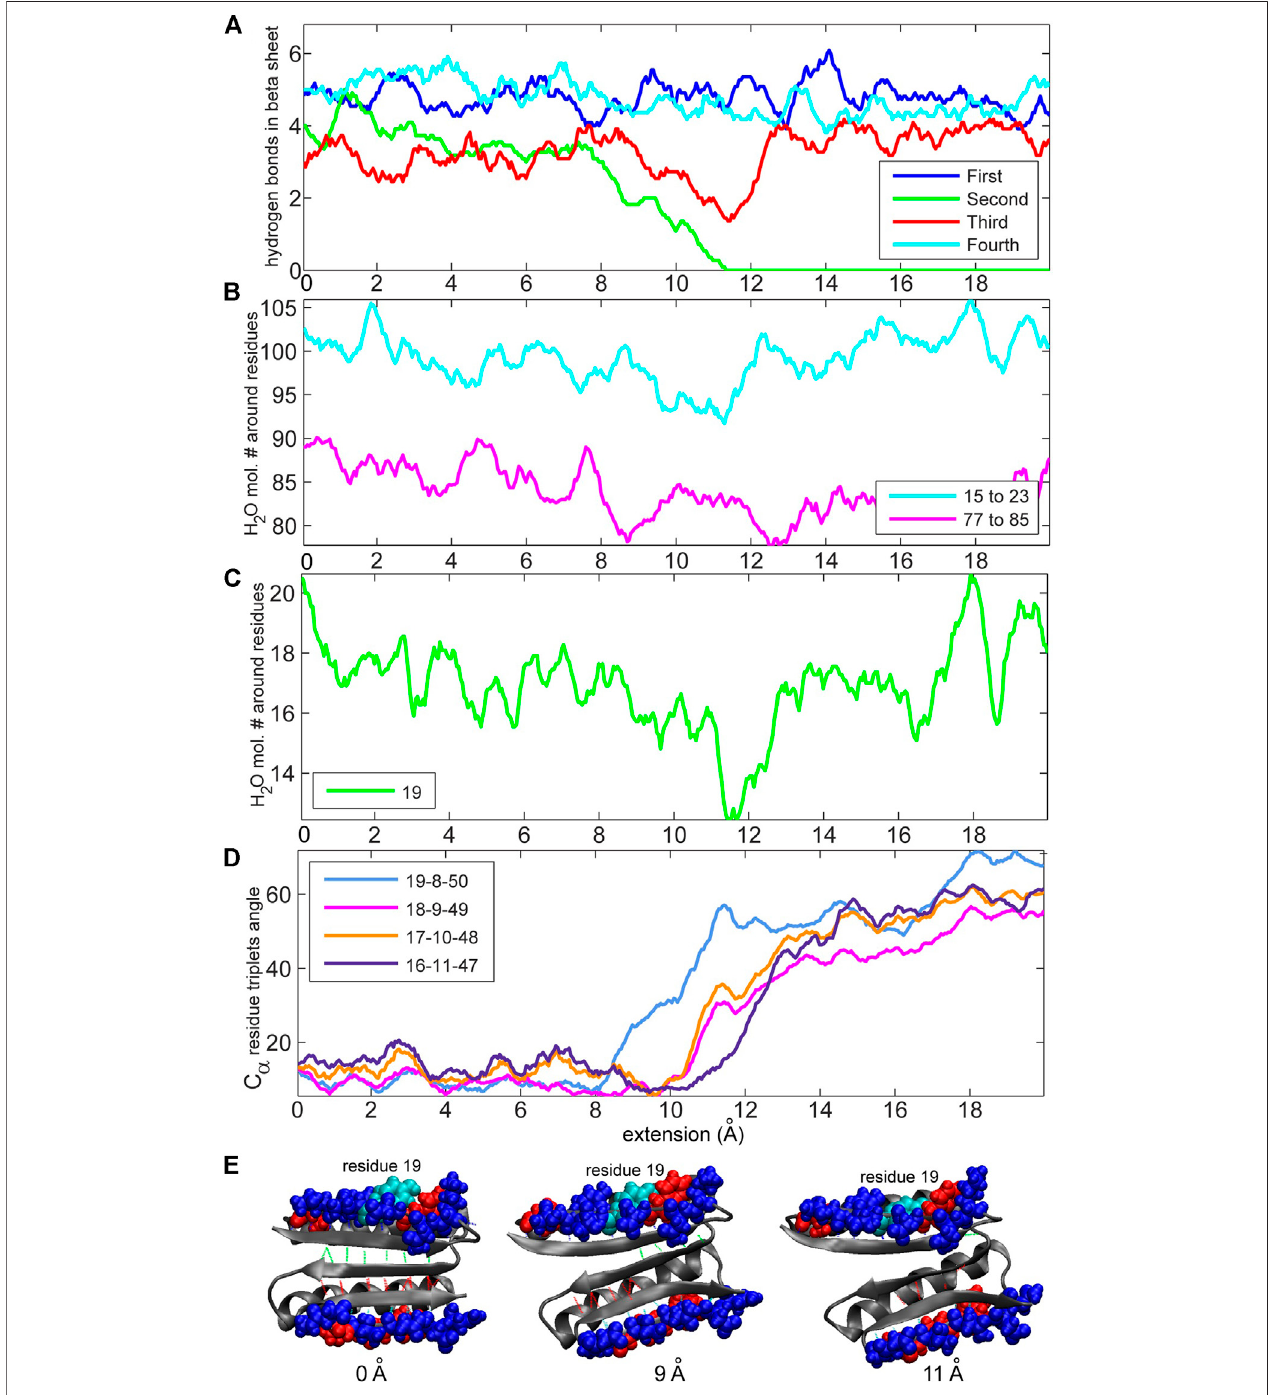
FIGURE 6 | Analyses of the numbers of hydrogen bonds vs. the concentration of water molecules and residue triplet angles (see Methods section) for the 10 m/s trajectory. (A) Numberofhydrogenbondsduringthesimulation.Thevaluesareobtainedthroughlow-pass fi ltering(movingaveragewithwindowwidth11frames,or ± 5 frames about sampling points). (B) Numbers of water molecules near residues 15 – 23 and 77 – 85. (C) Number of water molecules near residue 19. (D) Residue triplet angles for residue triplets 19 – 8 – 50, 18 – 9 – 49, 17 – 10 – 48, and 16 – 11 – 47 (triplet 19 – 8 – 50 is discussed in the text; the others are shown for comparison purposes). (E) Structure of the protein during pulling. Residue 19 (tyrosine is hydrophobic with a polar side chain) is colored cyan. Hydrophobic residues (15 – 23 and 77 – 85) are colored red, and hydrophilic residues are colored blue. Hydrophobic and hydrophilic residues in Figures 6 , 8 are displayed with VMD (Humphrey et al., 1996) by using the built-in atom selection